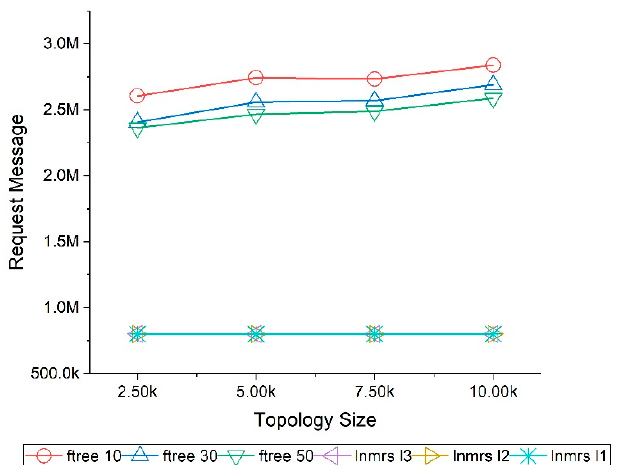
Figure 18. Number of messages generated during the resolution process.